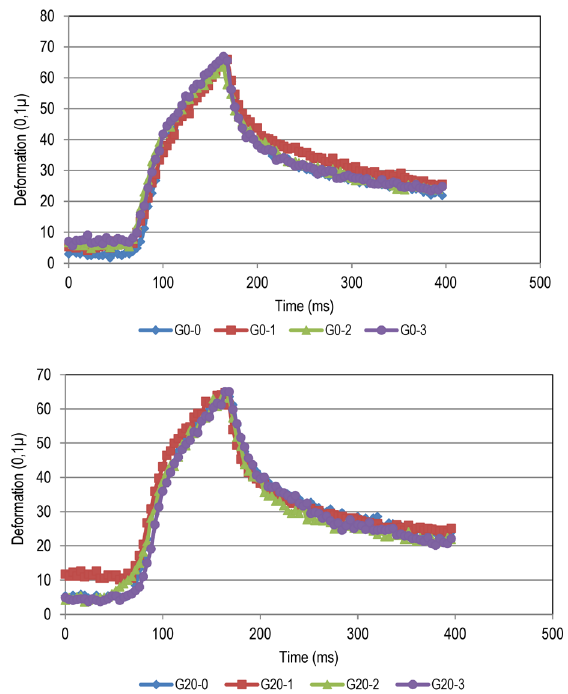
Fig. 6. The stress-deformation relation of the asphalt mixtures with graphite